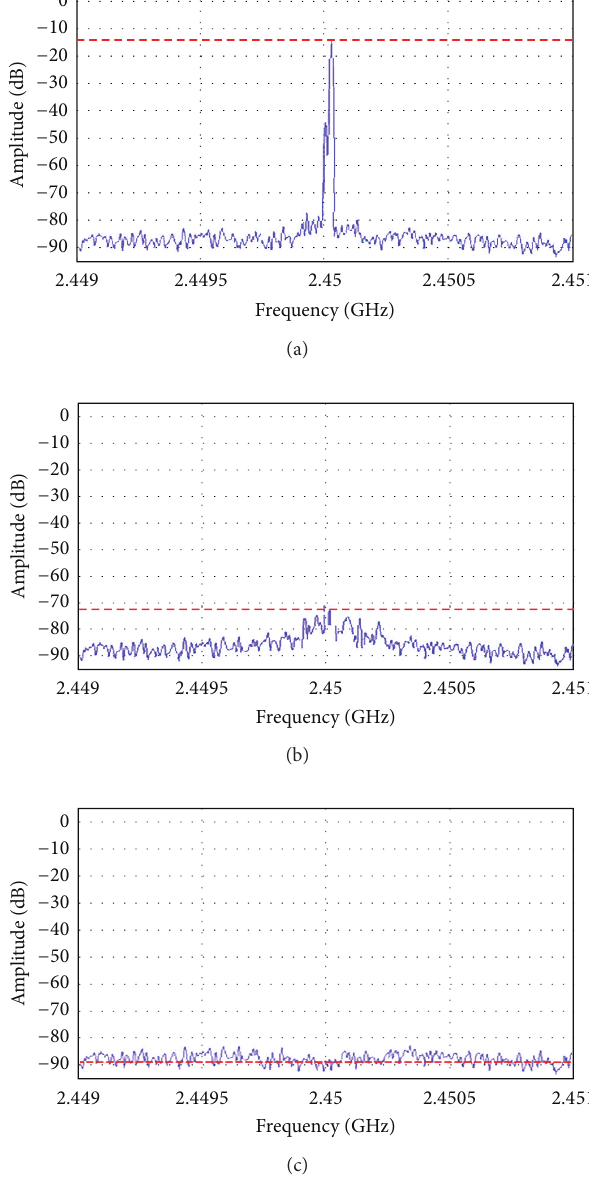
Figure 12: Measured spectrum of the self-interference signal (a) without any cancellations, (b) with RF interference cancellation but without digital interference cancellation, and (c) with both RF and digital interference cancellations.